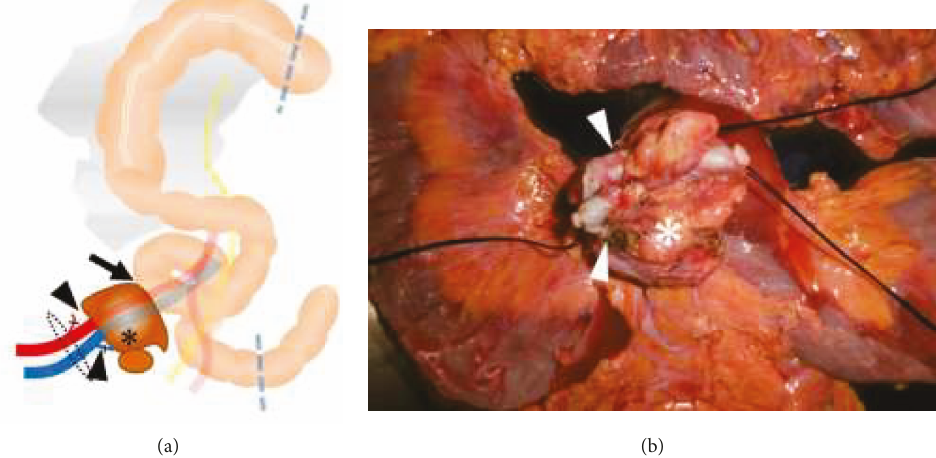
Figure 4: A femoro-femoral arterial bypass was performed, followed by an en bloc tumor resection. (a) The fi xed solid tumor ( ∗ ) at the right inguinal fossa. The tumor involved the external iliac artery, external iliac vein (arrowhead), ileum (arrow), and right obturator lymph nodes. The broken lines with blue color indicate the proximal and distal resection margins of the bowel. The broken lines with black-colored circle indicate the resection margin of the vessels. (b) Surgical specimen of the resection tumor ( ∗ ) that invaded, including both the external iliac artery and vein (arrowhead) as well as the small